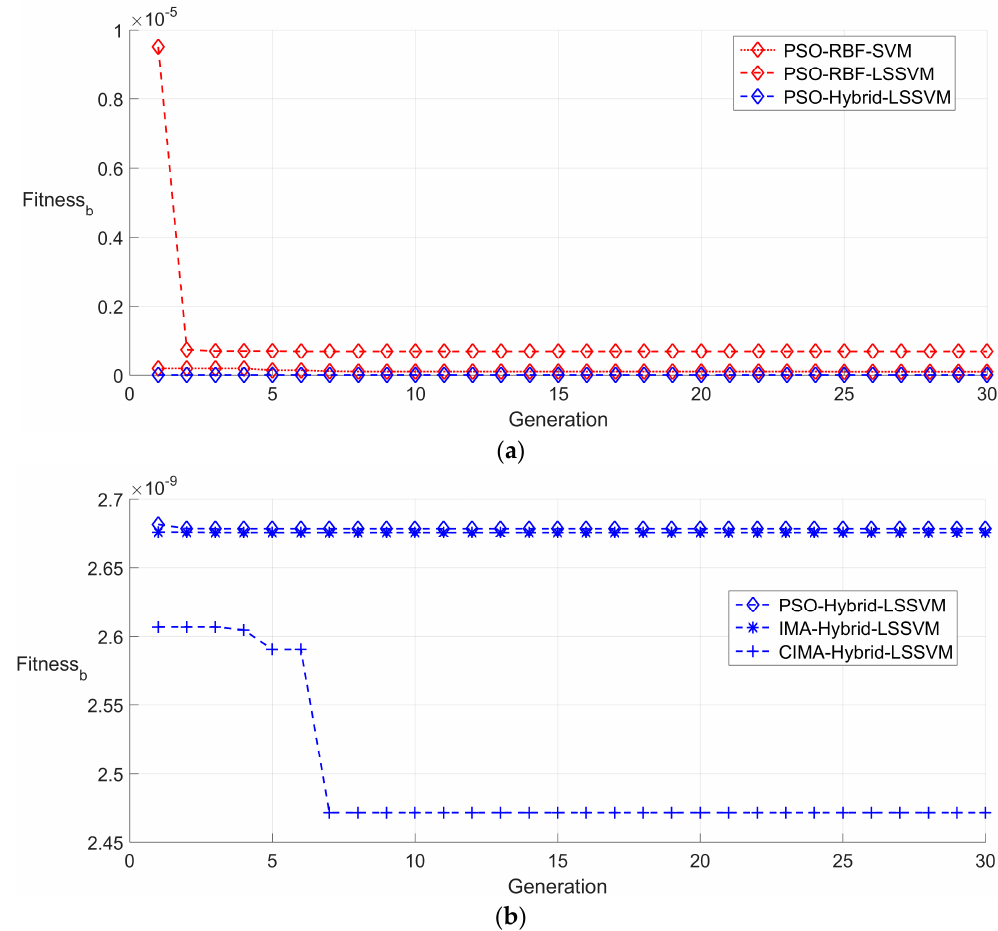
Figure 7. Best fitness of training set by random partition in 30 generations. ( a ) best fitness obtained by particle swarm optimization optimized RBF kernel SVM (PSO-RBF-SVM), particle swarm optimization optimized RBF kernel LSSVM (PSO-RBF-LSSVM) and particle swarm optimization optimized hybrid kernel LSSVM (PSO-Hybrid-LSSVM); and ( b ) best fitness obtained by particle swarm optimization optimized hybrid kernel LSSVM (PSO-Hybrid-LSSVM), ions motion algorithm optimized hybrid kernel LSSVM (IMA-Hybrid-LSSVM) and chaotic ions motion algorithm optimized hybrid kernel LSSVM (CIMA-Hybrid-LSSVM).